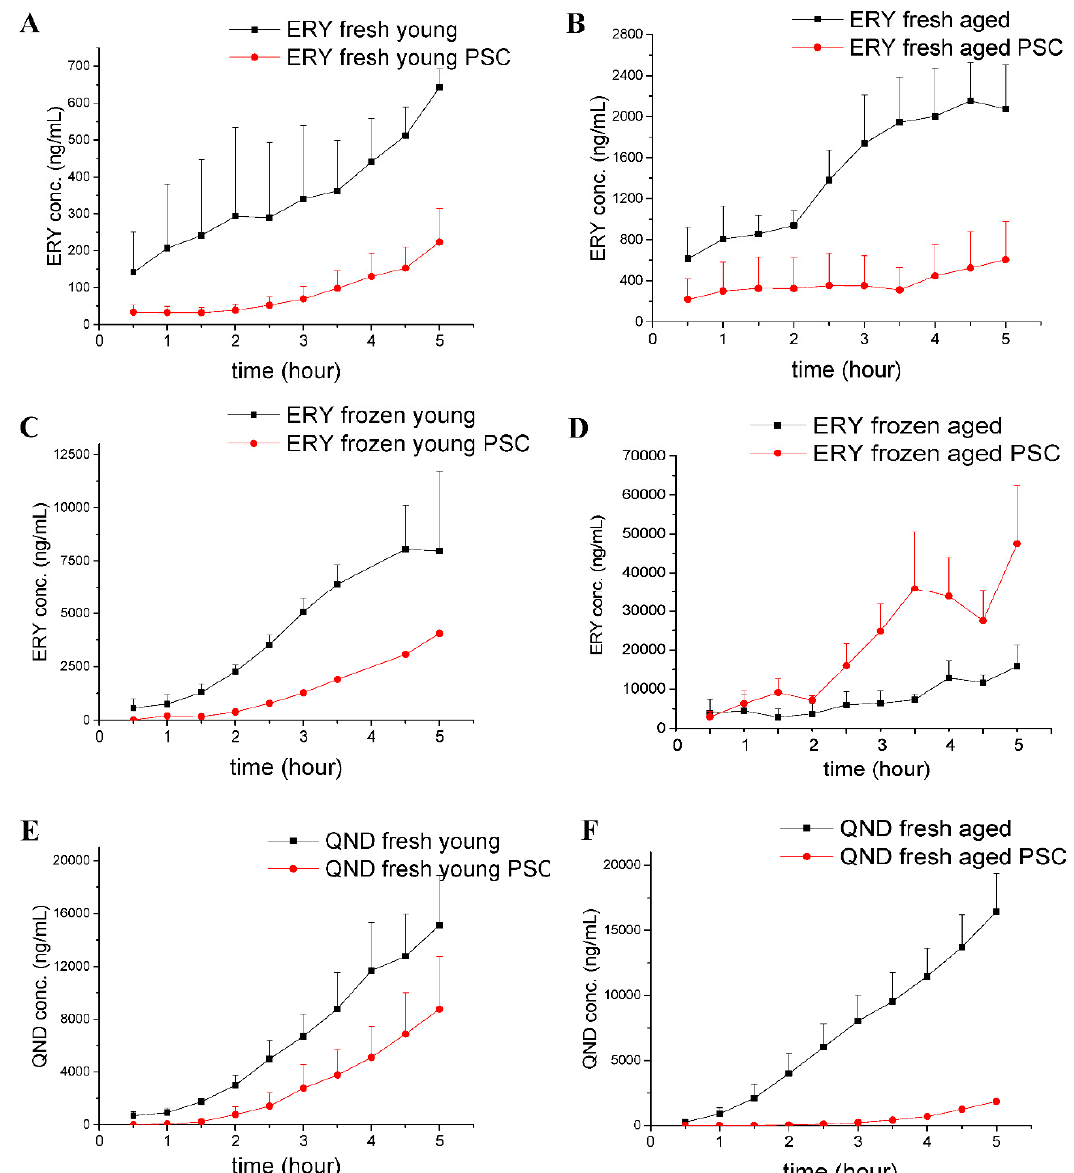
Figure 4. Concentration-time profiles determined in Franz diffusion cells in freshly prepared ( A , B , E , F ) and frozen ( C , D ) rat skin samples. Erythromycin (ERY) absorption was measured ( A – D ) in young ( A , C ) and aged ( B , D ) skin preparations. Quinidine (QND) absorption was measured ( E , F ) in young ( E ) and aged ( F ) skins. Both ERY and QND were applied as a 2% cream. The black lines show the groups where the skins were pretreated with DMSO followed by ERY or QND treatment. The red lines show the groups where the skins were pretreated with PSC-833 containing DMSO followed by ERY or QND treatment. n = 3. The statistical analysis of generated AUC and Cmax data is presented in Figures 5 and 6.